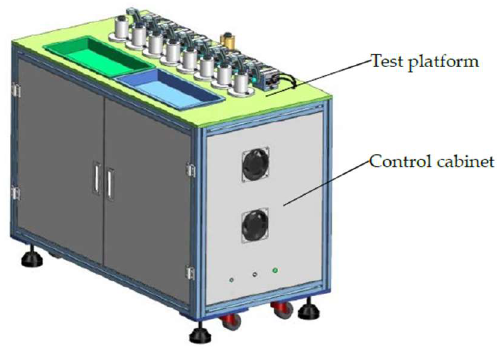
Figure 7. Composing of the automatic test system.